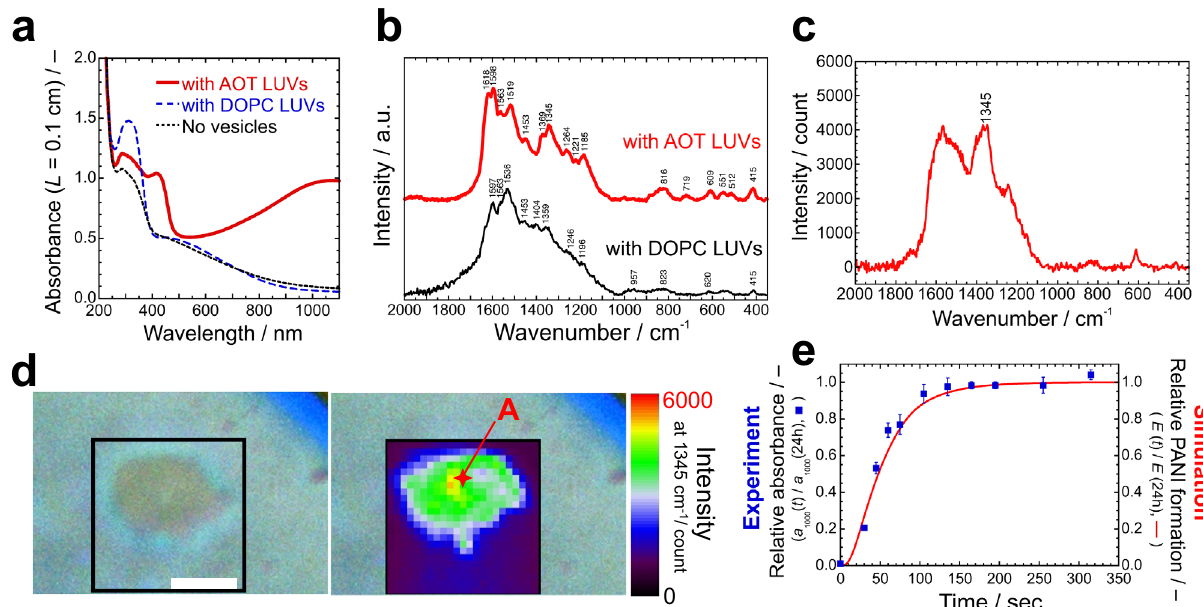
Fig. 2 Synthesis of PANI-ES on the surface of AOT vesicles. a UV/Vis/NIR absorption spectra of the polymerisation products. The absorption spectra of the products were obtained by polymerisation of aniline in the presence of AOT LUVs under the optimised cascade reaction conditions (red solid line, see Methods ). For reference, the absorption spectra of the products obtained from the polymerisation of aniline either in the presence of DOPC LUVs (blue dashed line) or in the absence of any LUVs (black dotted line) are also shown. All spectra were recorded 24 h after the start of the reactions at T ~25 ˚ C. b Raman spectra of the products obtained by the polymerisation of aniline in the presence of either AOT LUVs (red thick line) or DOPC LUVs (black solid line) under the optimised cascade reaction conditions. The spectra were recorded at T ~25 ˚ C after ~24 h from the start of the reaction, see Methods . c Micro-Raman spectra of an AOT/PANI-ES GUV obtained under the optimised cascade reaction conditions. The sampling point is shown as point “ A ” in d . The spectrum was recorded after ~24 h from the start of the reaction at T ~25 ˚ C. The laser spot size was 520 nm in diameter and 680 nm in depth. d Spatial Raman mapping of an AOT/PANI-ES GUV using the 1345 cm − 1 peak, which is characteristic for the delocalised polarons of PANI-ES. Microscope bright fi eld image (left) and Raman mapping image (right) of an AOT/PANI-ES GUV are shown. The scanning was started after ~24h from the start of the reaction at T ~25 ˚ C. The shadow in the upper right is caused by the wall of the glass tube. Length of the scale bar: 5 µ m. e Time-dependence of the relative absorbance at λ = 1000 nm of the UV/Vis/NIR absorption spectra obtained from the polymerisation products of aniline in the presence of AOT LUVs under the optimised cascade reaction conditions (blue squares). The absorbance at λ = 1000 nm ( a 1000 ( t )) is normalised by the absorbance after 24 h from the start of the reaction ( a 1000 (24 h)). The red line is the theoretical prediction obtained by the kinetic model (model-2, see Supplementary Note 3- 3(ii)). The error bars indicate standard deviations estimated from three different